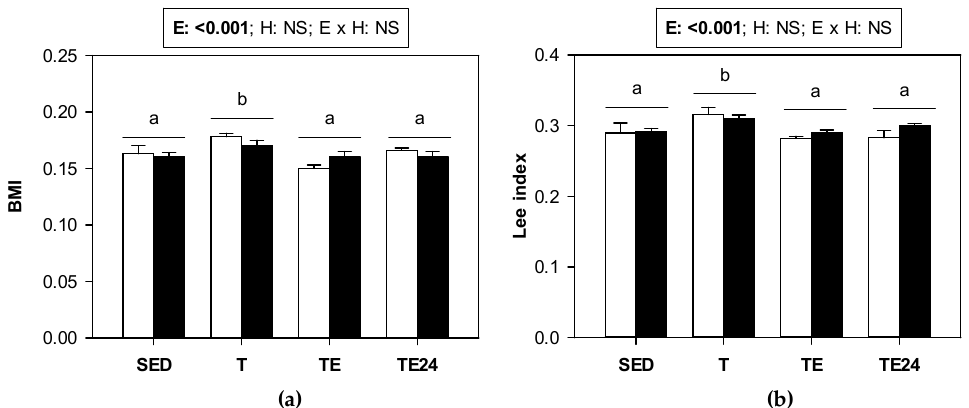
Figure 1. ( a ) Body mass index (BMI) and ( b ) Lee index in sedentary (SED) and runner rats (training for five weeks) that were classified into T group, with values obtained 24 h after a regular training session, TE group, with values obtained immediately after a final exhaustion test, and TE24 group, with values obtained 24 h after the final exhaustion test. The non-supplemented groups are represented by white bars and the hesperidin-supplemented groups by black bars. E = exercise; H: hesperidin supplementation; E × H = interaction between E and H; NS = no significant differences. Data are expressed as mean ± SEM ( n = 8). Different letters between groups indicate significant differences ( p < 0.05) due to exercise.